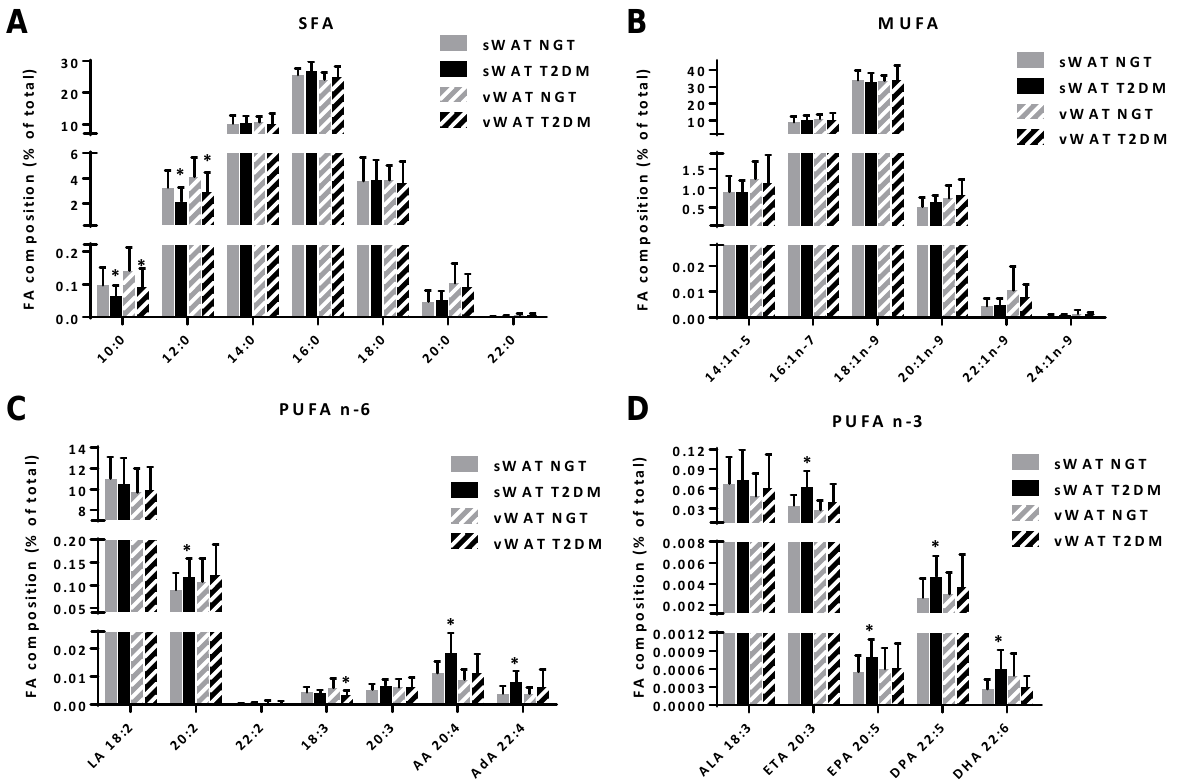
Figure 1. Fatty acid composition of white adipose tissue (sWAT) and visceral adipose tissue (vWAT) for normal glucose tolerance (NGT) versus type 2 diabetes mellitus (T2DM) individuals. ( A ) Saturated fatty acids; ( B ) mono-unsaturated fatty acids; ( C ) n -6 and ( D ) n -3 poly-unsaturated fatty acids. Data are expressed as mean ± standard deviation (SD). * p < 0.05 for NGT versus T2DM.